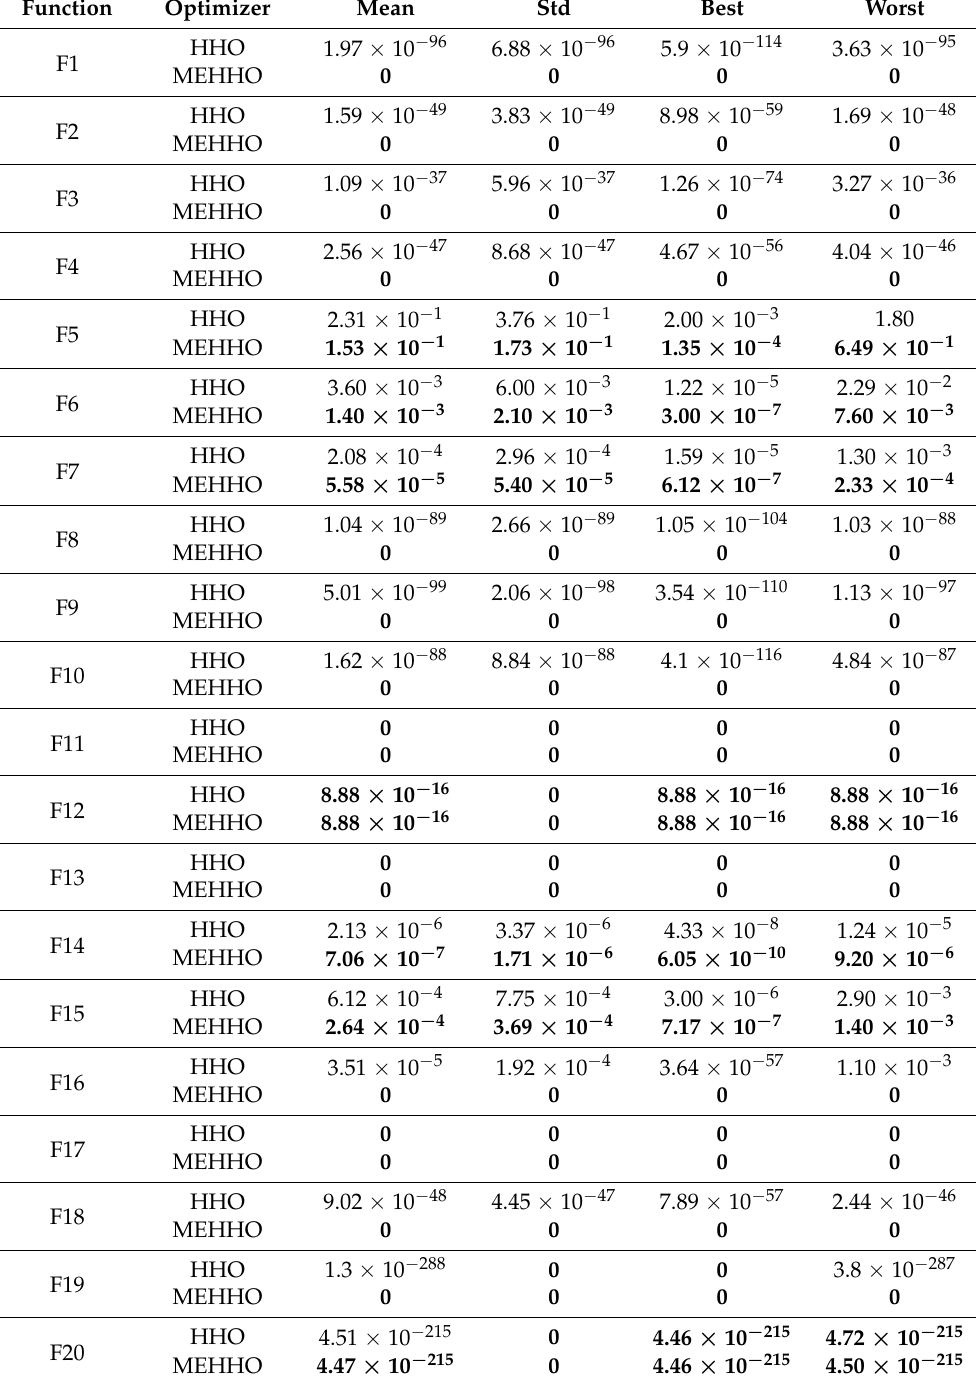
Table 9. Results comparison of variable-dimensional functions (500